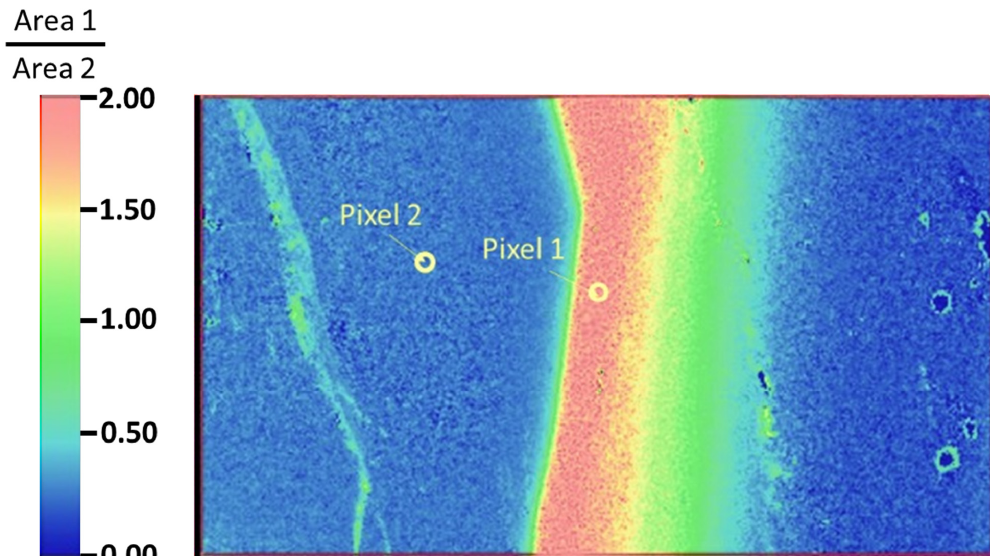
Figure 23. High-resolution Raman map of a portion of the tourmaline shown in Figure 21. Color bar represents the ratio of area 1 to area 2 (see Figure 22), which varies across the analyzed portion. Pixel size is 10 µm and it required 16 h and 24 min to generate this map.